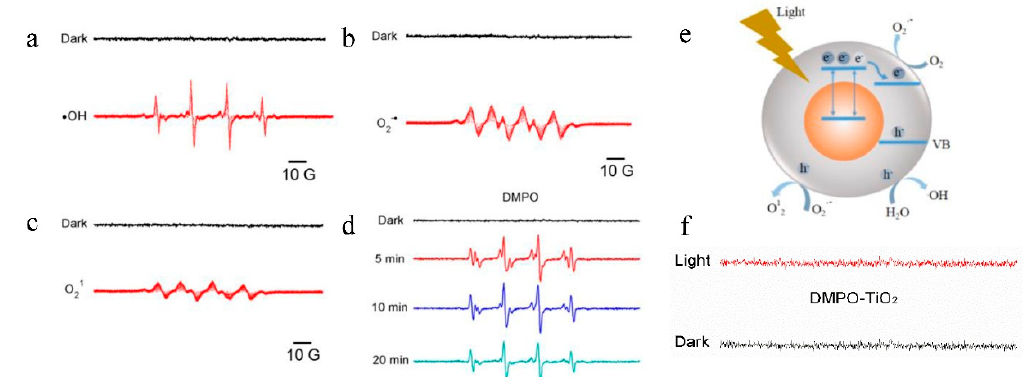
Figure 5. The electron spin resonance (ERS) results of ( a ) OH • radical and O 2 • radial under ( b ) dark and ( c ) light conditions; ( d ) Intensity change of OH • radical for different irradiation time; ( e ) Mechanism of radical generation; ( f ) Comparison of ERS results of the TiO 2 nanoparticles.